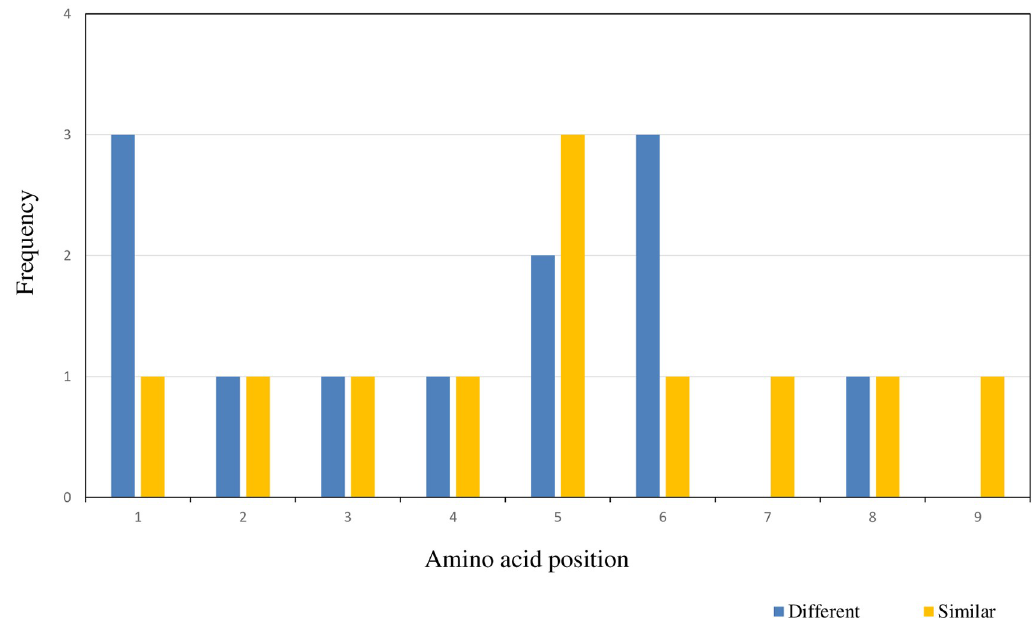
Fig 2. Frequency of polymorphic residue distribution at each amino acid position within test peptides. Numbers are based on data presented in Tables 1 to 4. For each residue position, amino acid substitutions that resulted in statistically significant differences in the magnitude of IFN- γ responses between allelic peptides are designated as “Different” (in blue colour) and substitutions that did not result in statistically significant changes in IFN- γ responses between allelic peptides are designated “Similar” (in yellow